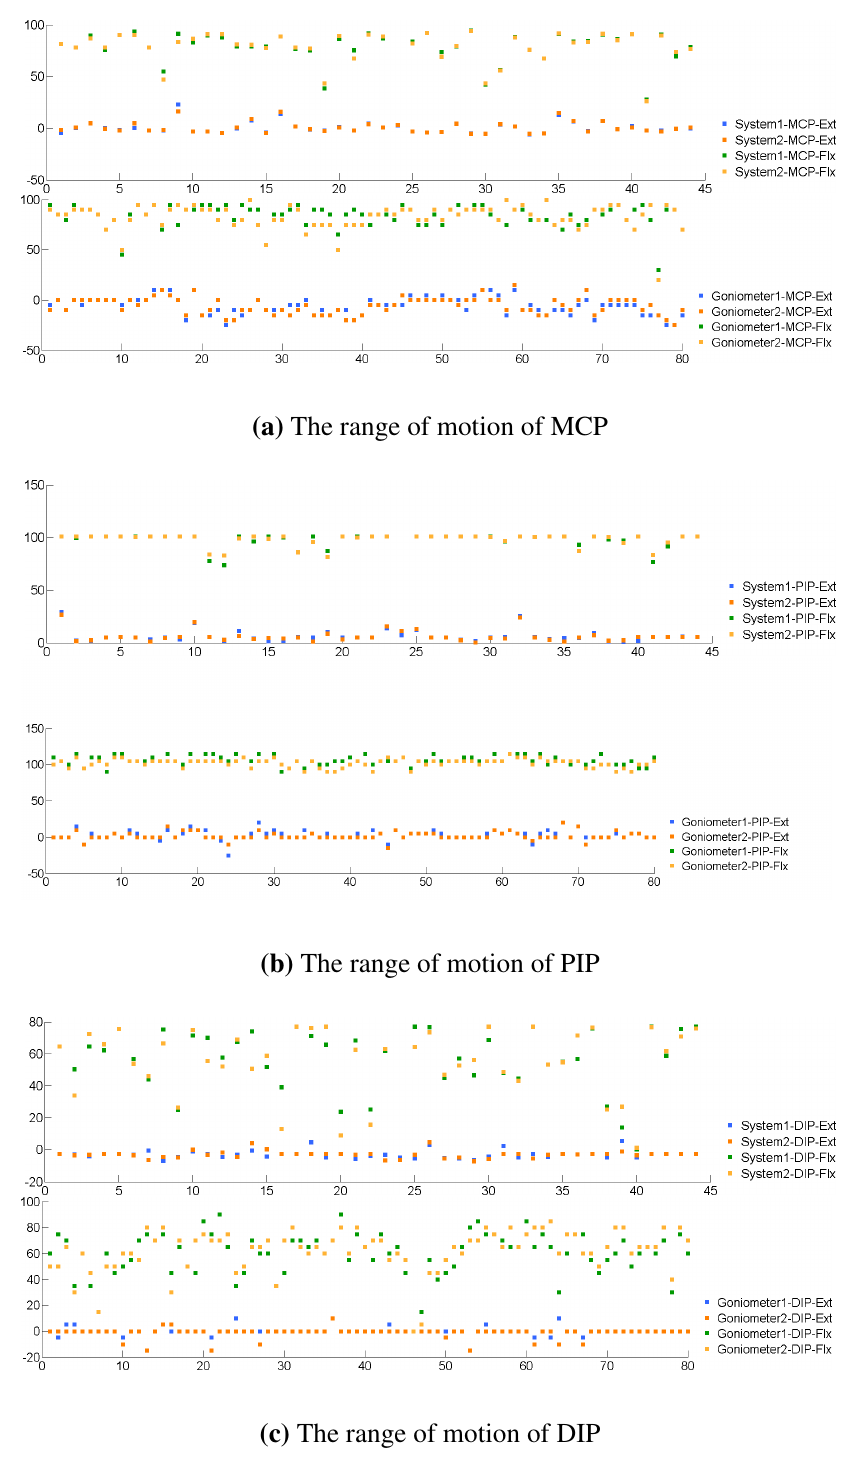
Figure 10. The range of motion (ROM) of MCP, PIP and DIP measured twice by either the proposed system or therapists. The values from 1–40 and from 41–80 on the x-axis are the left hands of 40 subjects and the right hands of 40 subjects,